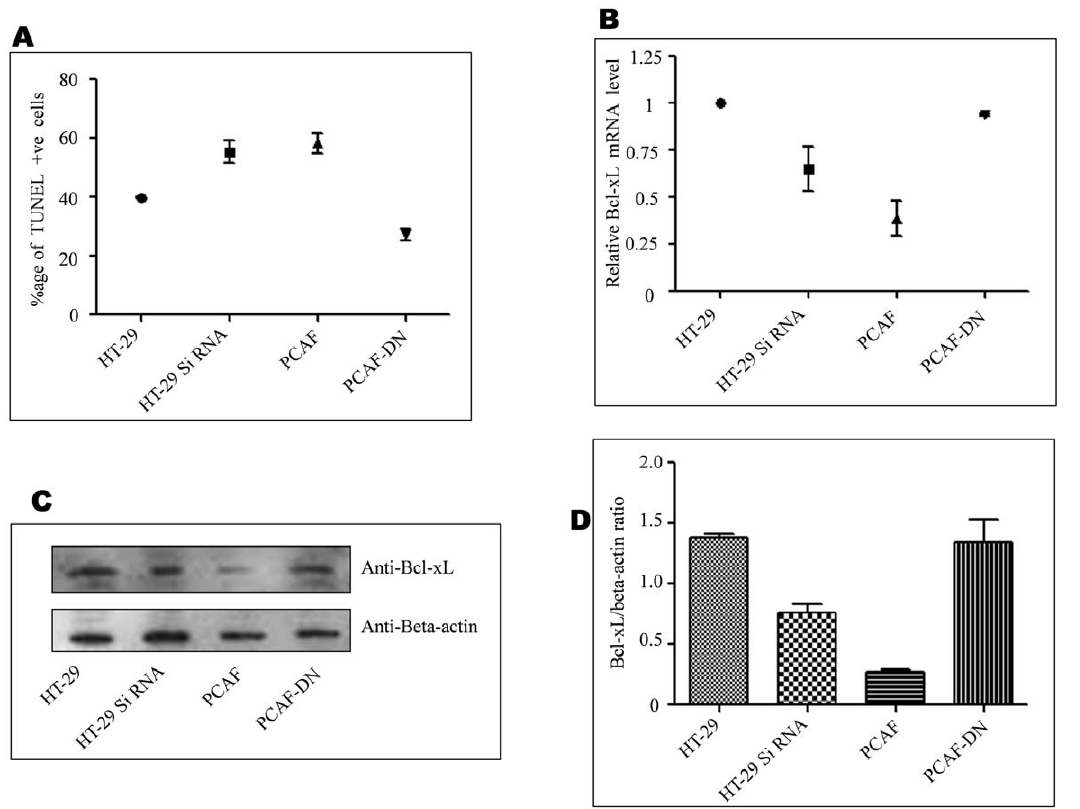
Figure 5. Acetylation of EVI1 induces apoptosis in HT-29 cells (TUNEL assay). A. HT-29 cells were transfected and treated as above (Figure 4). After thirty six hours of transfection, cells were stained with TUNEL reagent (BD biosciences, USA) as per the instruction of the manufacturer. The approximate percentages of cells that are positive for TUNEL are 41, 55, 58 and 28 for HT-29 cells, EVI1 specific siRNA transfected HT-29 cells, PCAF-wt or PCAF-DN transfected HT-29 cells respectively (p value=0.0036). B. A part of the same transfected cells that were used for apoptosis assay was checked for the BCL-XL mRNA level through real time PCR. As shown Bcl-xL mRNA level was higher in HT-29 cells however it was reduced when EVI1 siRNA or PCAF was transfected in the HT-29 cells. Expression of PCAF-DN again increased the Bcl-xL mRNA level (p value=0.0016). C. Another part of the same transfected cells that were used for apoptosis assay was checked for the BCL-XL protein expression with Bcl-xL antibody (Imgenex India Pvt. Ltd.) and beta-actin antibody (Santa Cruz) through western blotting. As shown BCL-XL expression was higher in HT-29 cells however BCL-XL expression was reduced when EVI1 siRNA or PCAF was transfected in the HT-29 cells. Expression of PCAF-DN again increased the BCL-XL expression. D. The same western blotting data was quantified by Bio-rad gel doc volume analysis method. Figure shows a quantification of Bcl-xL with respect to the beta actin (p value=0.0039).